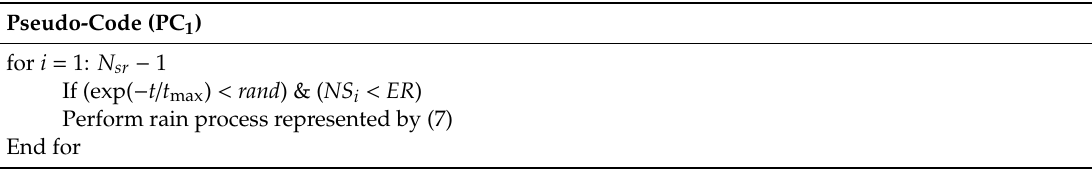
Table 2. Pseudo-code of the whole evaporation process of the river.